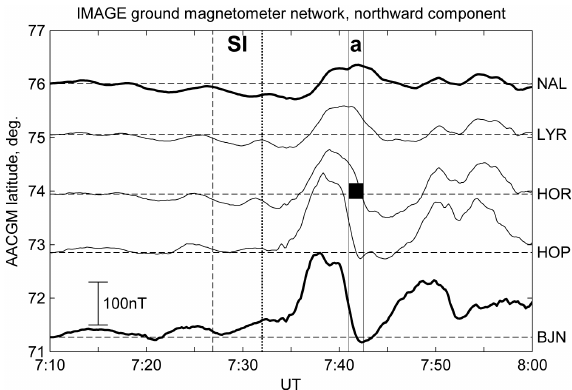
Fig. 10. Magnetic disturbances ( H -component) according to the IMAGE magnetometer network around Svalbard between 07:10 UT and 08:00 UT. Vertical dashed and dotted lines indicate the mo- ments of the pulse arrival at the bow shock and its detection at the low-latitude magnetic observatory Bangui, respectively. Au- roral form “a” (see Fig. 6) was observed at latitudes of a change in the sign of the magnetic disturbance (+ in LYR and − in HOP), indicating a shear in the E–W plasma